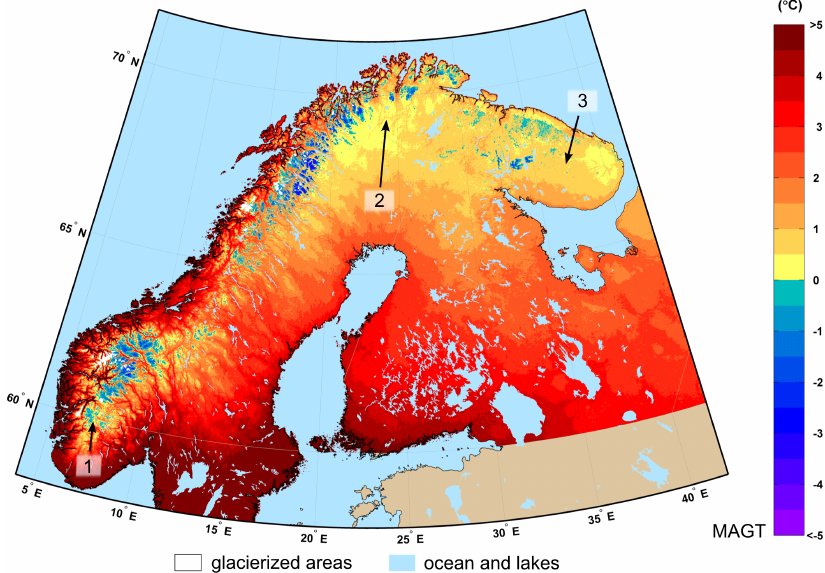
Figure 7. Average MAGT of all model realizations for Scandinavia. 1: Hardangervidda; 2: Finnmarksvidda; 3: Kola Peninsula. Glacierized areas from Natural Earth